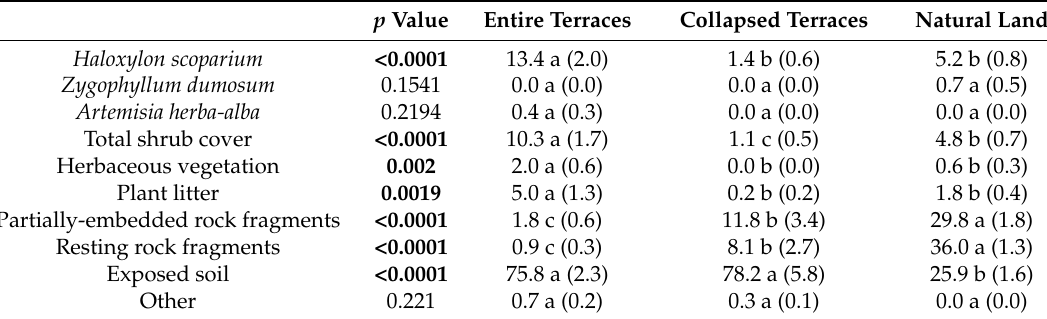
Table 1. Land-use effect on ground surface cover